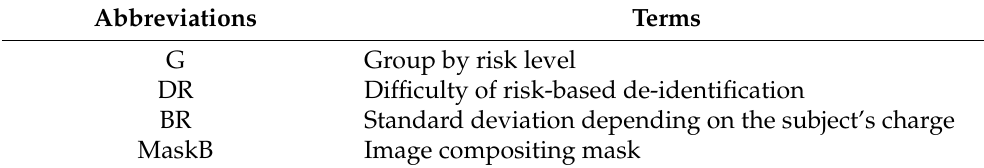
Table 3. Defined